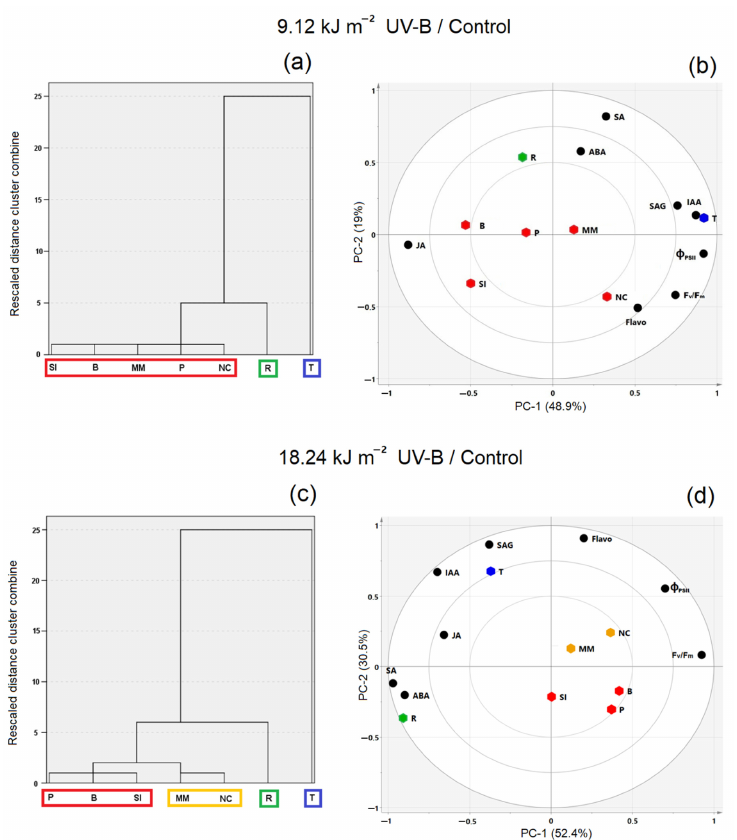
Figure 4. Dendrogram and Principal Component Analysis (PCA; percentage of explained variance of the models, 67.9 ( b ) and 82.9% ( d )) plots corresponding to seven quinoa varieties exposed to 9.12 and 18.24 kJ m − 2 UV-B ( a , b and c , d , respec- tively). Clusters in dendrogram were color-linked to scores in PCA. Circles indicate 50 and 100% limits for the explained variance of the PCA models. Scores: Quinoa variety real (R), titicaca (T), minttumatilda (MM), negra collana (NC), pasankalla (P), salcedo INIA (SI) and blanca (B). Loadings: Photosynthesis-related parameters ( F v / F m and Φ PSII ), flavonoids (Flavo) and hormones (IAA, SA, SAG, JA and ABA).